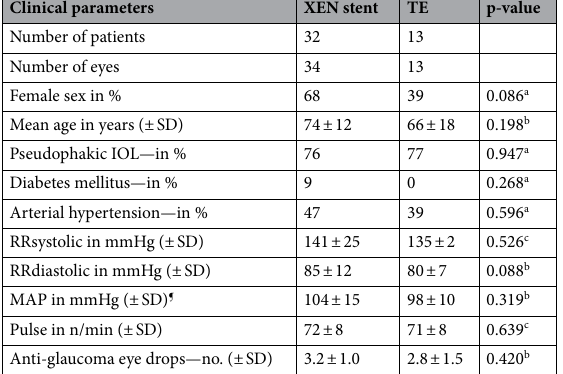
Table 1. Clinical characteristics of the patients at baseline. IOL intraocular lens, RR Riva-Rocci blood pressure, MAP mean arterial pressure. ¶ The mean arterial pressure is the diastolic pressure added to one third of the difference between systolic and diastolic pressure in mmHg. a Chi-Quadrat test. b Mann-Whitney U test. c t